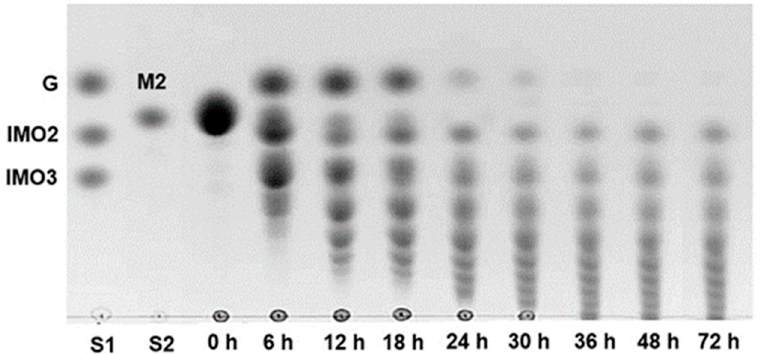
Figure 1. TLC pa tt erns of culture supernatant of B. subtilis strain AP-1 grown in MS medium containing 5% ( w / v ) maltose. Lane S1: glucose (G), isomaltose (IMO2) and isomaltotriose (IMO3) standard; lane S2: maltose (M2) standard.